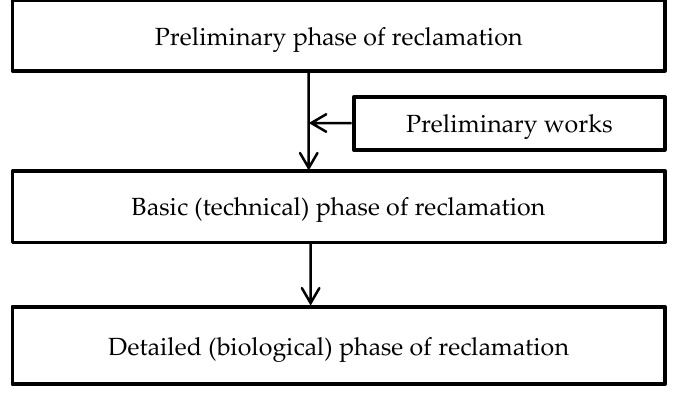
Figure 1. Reclamation phases.